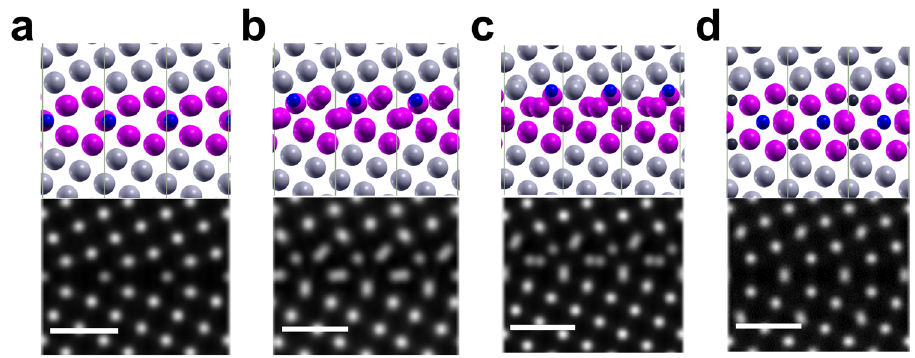
Fig. 8 Disorder at the GB for B at substitutional segregation sites. The upper panels of a , b and c show the DFT calculated structures with B (blue) at substitutional sites 1, 2, 3. The lower panels are the corresponding HAADF-STEM simulated structures. d shows the GB segregated with two B (in one column) and two C (brown) atoms from Fig. 9f (see below). The scale bar is